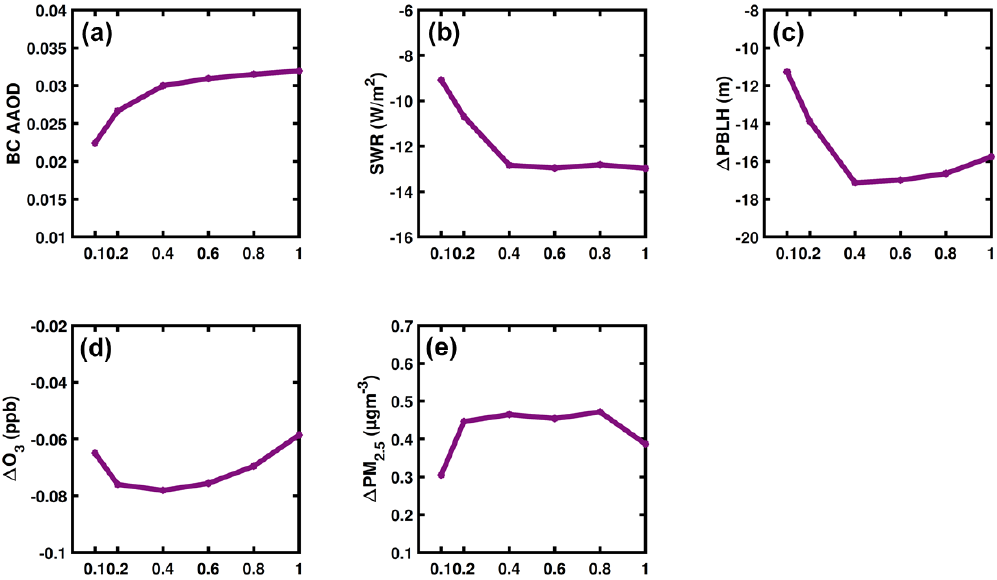
Figure 9. Daytime (10:00–17:00 local time) mean BC AAOD in Beijing (a) BC absorption induced changes in shortwave radiation (b) , PBLH (c) , O 3 (d) , and PM 2 . 5 (e) as a function of the fraction of non-BC particles mixed with